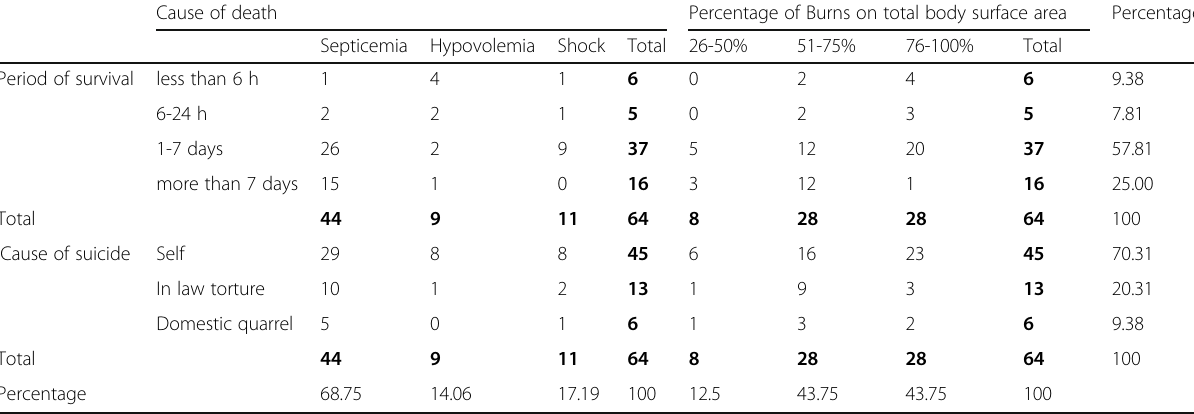
Table 3 Period of survival & cause of Suicide wise cause of Death & percentage of burns Cause of